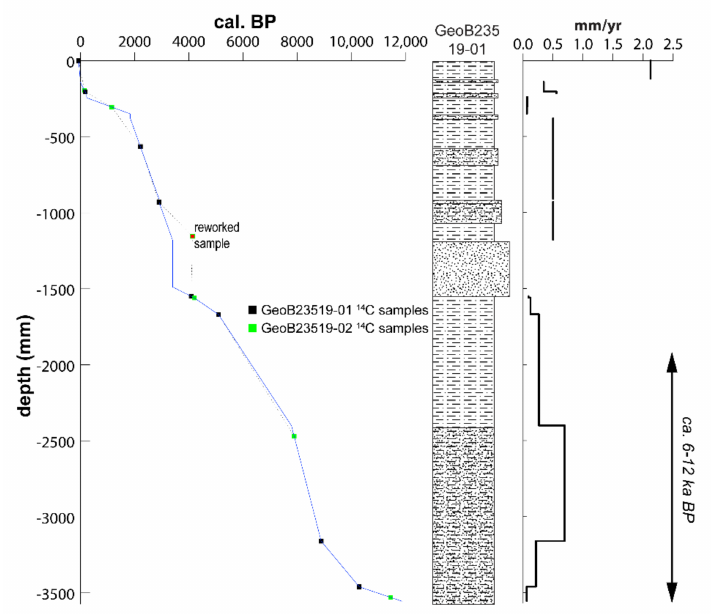
Figure 3. Age model, sedimentation rates and lithological log for core 19-01. Key for lithologies as Figure